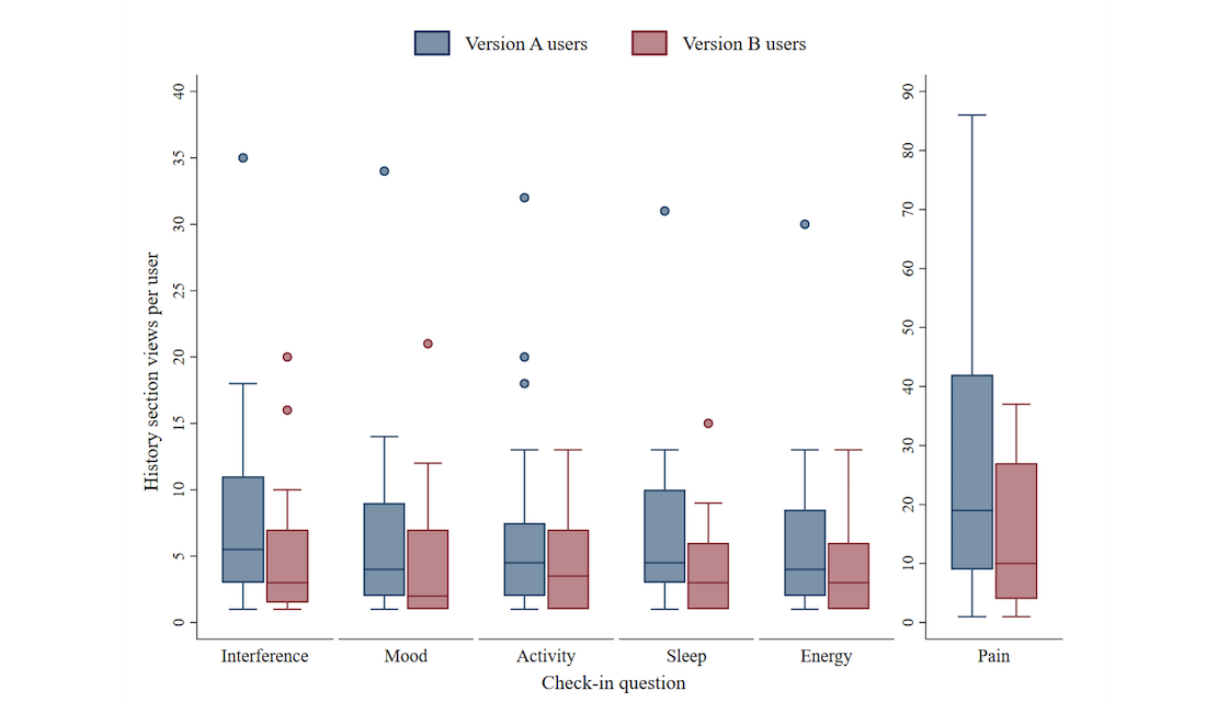
Figure 4. Interaction with the iCanCope History function to view symptom trends. The central line within each box denotes the median view count; the lower and upper box hinges denote the 25th and 75th percentiles, respectively; adjacent lines of the whiskers represent the lower and upper adjacent values, respectively; data points above each box represent outlier